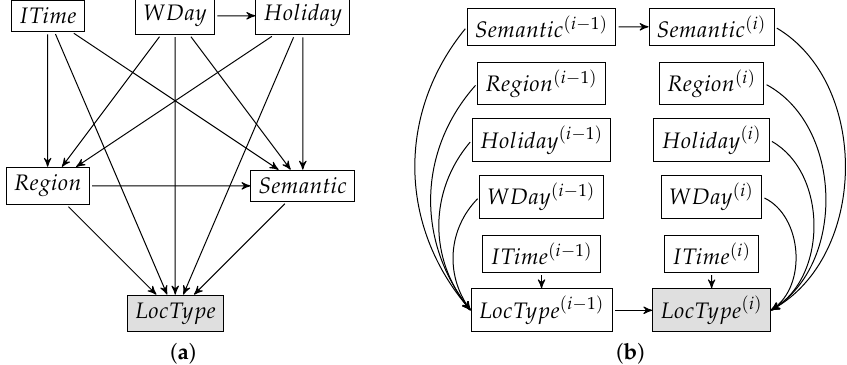
Figure 1. ( a ) Bayesian Network structure; ( b ) Dynamic Bayesian Network transition